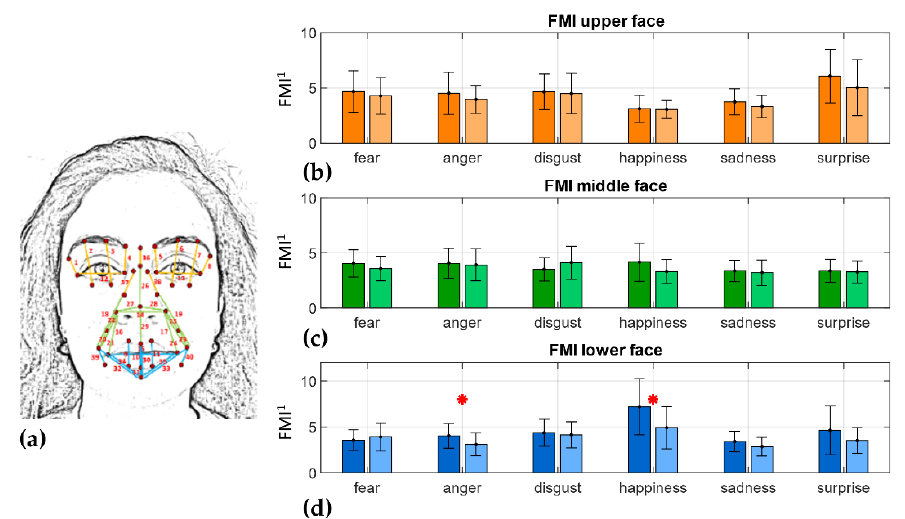
Figure 6. FMI per face region. ( a ) Distances grouped by face region; orange: upper face, green: middle face, blue: lower face; ( b ) FMI_up ; ( c ) FMI_mid ; ( d ) FMI_low . Darker colors refer to HC subjects, lighter colors to the PD cohort of subjects. Bar plot of the FMI values are reported as mean ± SD per cohort. Red * highlights statistically significant differences at the 0.05 confidence level. FMI 1 is dimensionless.